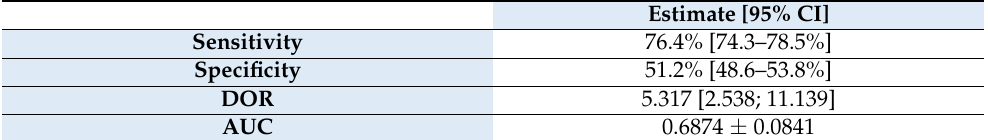
Table 2. Detection of extrathyroidal extension by